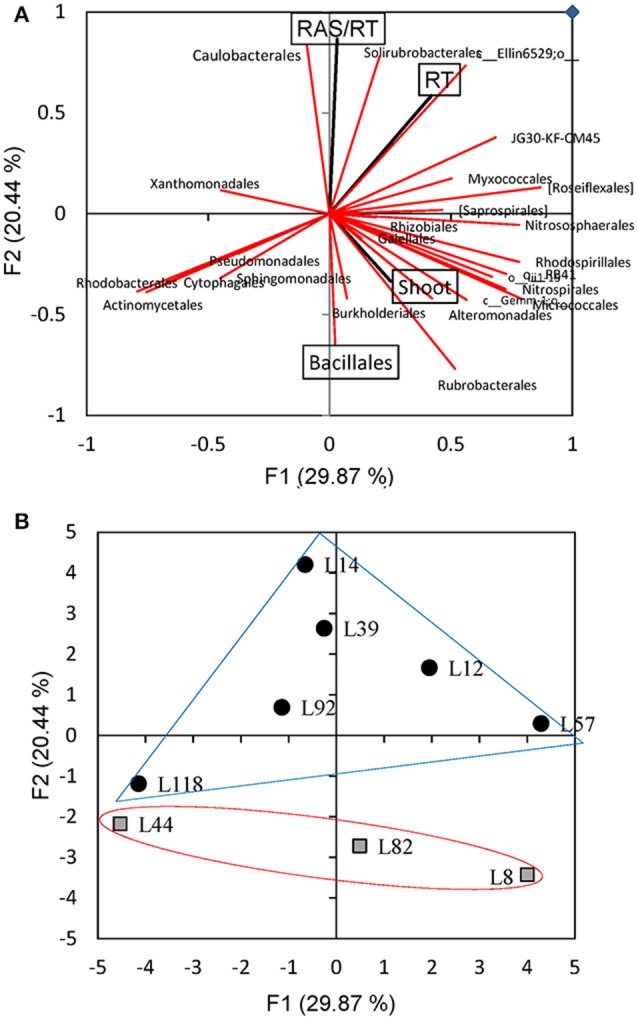
Principal component analysis of RAS/RT, shoot dm, root dm, and abundances of the 26 main bacterial orders found in the rhizosphere of 9 pearl millet inbred lines. (A) Plot of the loadings of the variables with principal components F1 and F2. (B) Projection in F1*F2 plan of rhizosphere soil samples from the different millet lines.